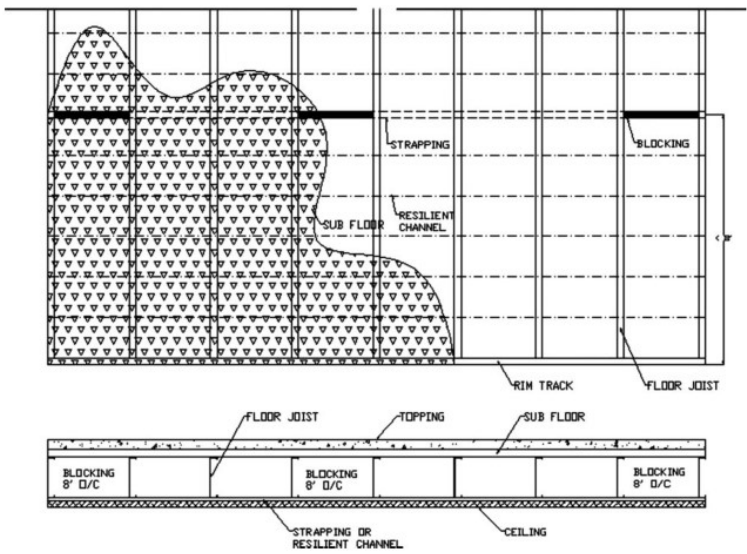
Figure 3. The plan-view and cross-section of the cold-formed steel floor in Parnell et al. [35]. Repro- duced with permission.